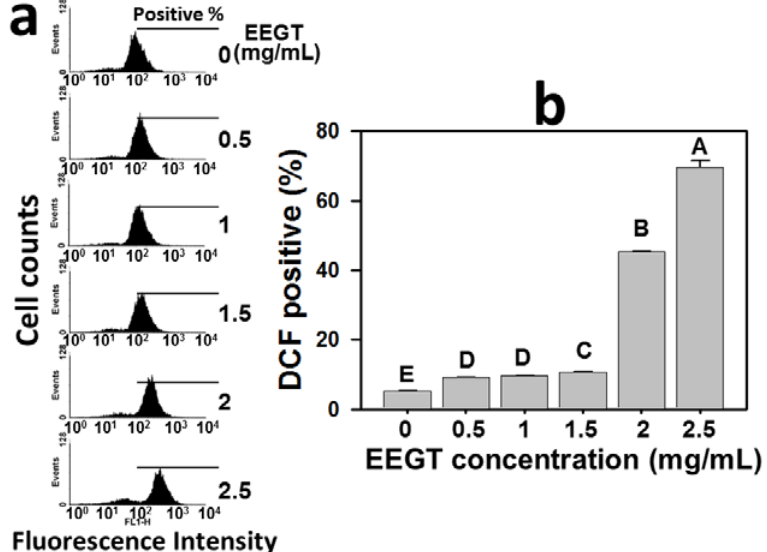
Figure 4. Ethanolic extracts of G. tenuistipitata (EEGT) increased reactive oxygen species (ROS) levels of Ca9-22 oral cancer cells. ( a ) Flow cytometry-based ROS profiles for EEGT-treated cells. Cells treated with different concentrations (0 to 2.5 mg/mL) of EEGT for 24 h. Positive % is indicated in each panel; ( b ) Quantificative analysis of DCF-positive population. Data are presented as mean ± S.D. (n = 3). Differences between treatments of different concentrations containing the same capital letter at the top of each column are not significant.